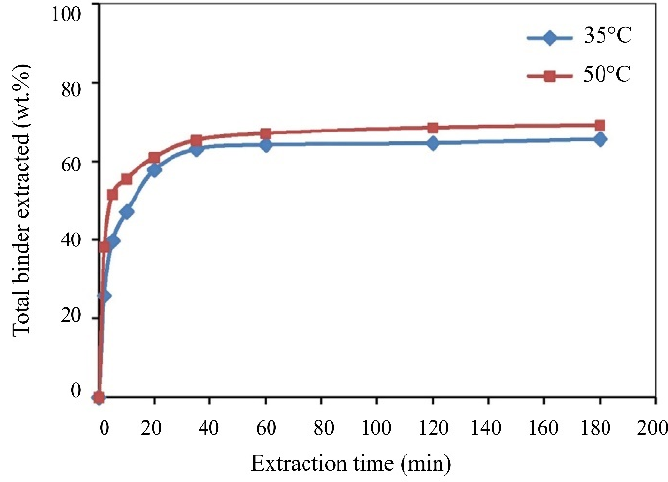
Figure 13. Effects of debinding temperature and time on the amount of the binder system removed during solvent debinding. Reproduced with permission from reference [33], copyright © 2014 Elsevier B.V.